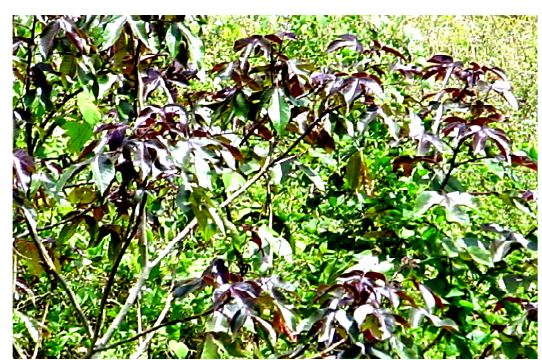
FIGURA 2 - Exposição da bexiga